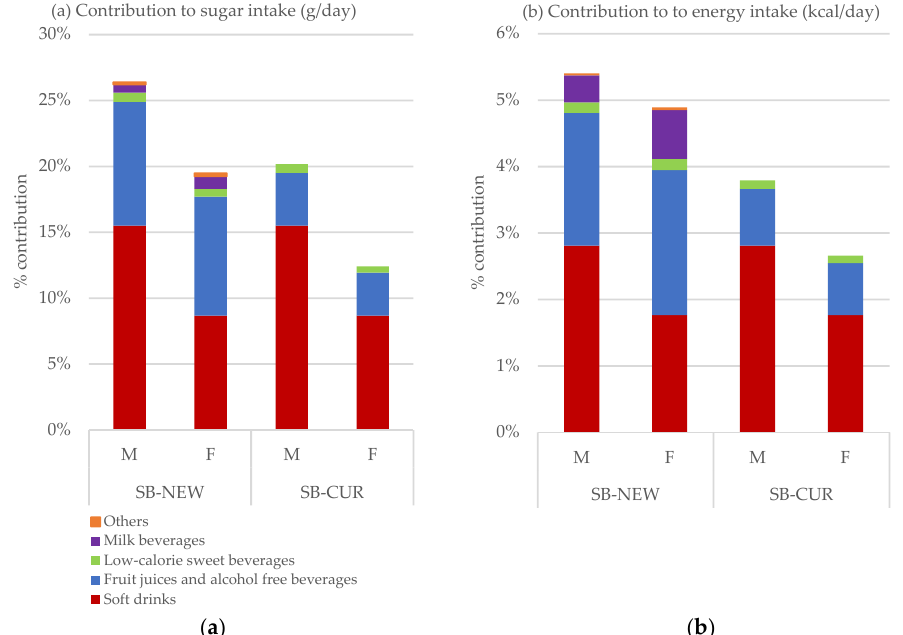
Figure 3. Weighted contribution of sweet beverages estimated by SB–NEW and SB–CUR to total sugar, (g / day) in ( a ) and to energy (kcal / day) in ( b ), from all foods and drinks by sex. SB–NEW includes all beverages; SB–CUR excludes 100% juices (no added sugar), milk beverages and other beverages with added sugar or sweetener, as defined in Table 1. All results were weighted for sex, age, marital status, major area of Switzerland, nationality, and household size. Di ff erences in the means between the SB–CUR and SB–NEW definition by gender were statistically significant with ANOVA ( p < 0.001). For men, SB–NEW consumption provided 5.4% of total energy intake (3.8% by SB-CUR), compared with 4.9% (2.7% by SB–CUR) for